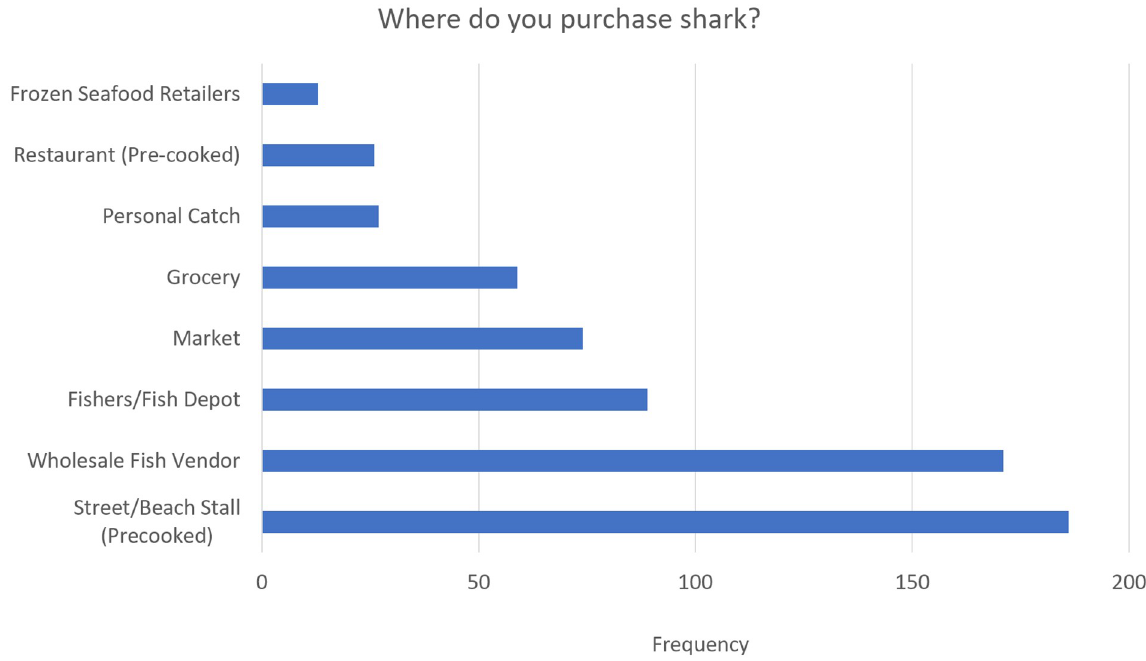
Fig 9. Popularity of different venues for purchasing shark. (See S3 Appendix for